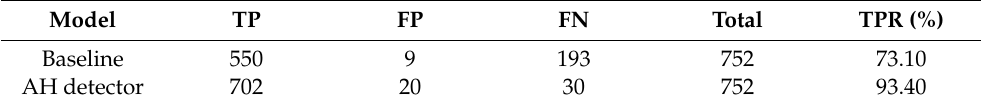
Table 6. Comparison between detection models to observe an increase in sensitivity and TP.